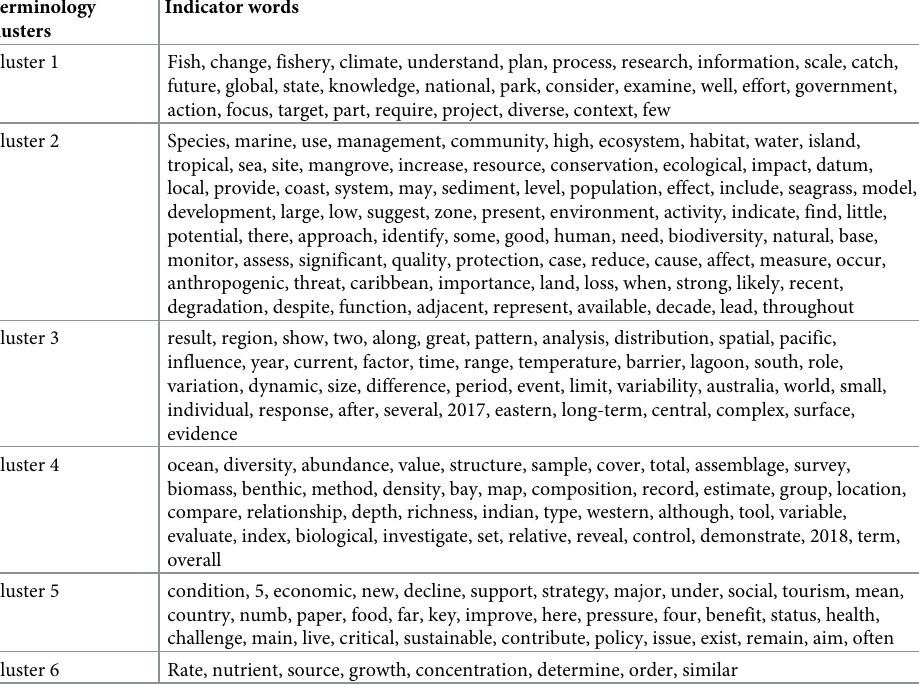
Table 6. Clustering of 248 indicator words into six terminology groups, based on their co-occurrence in 1328